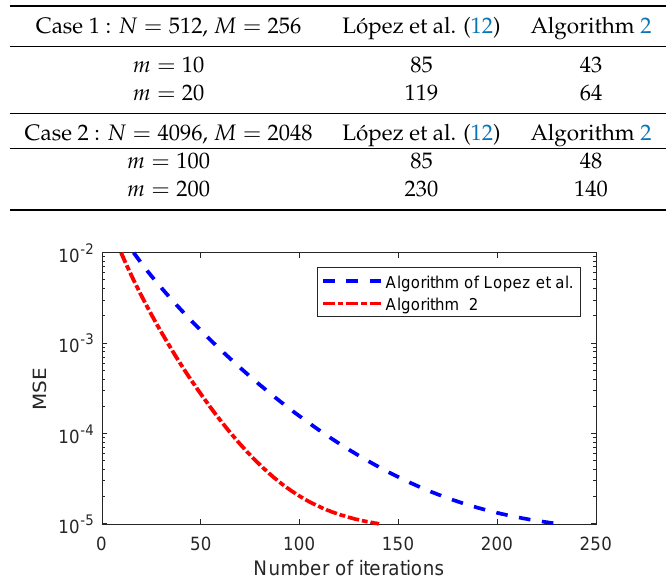
Table 2. Number of iterations for Algorithm 2.